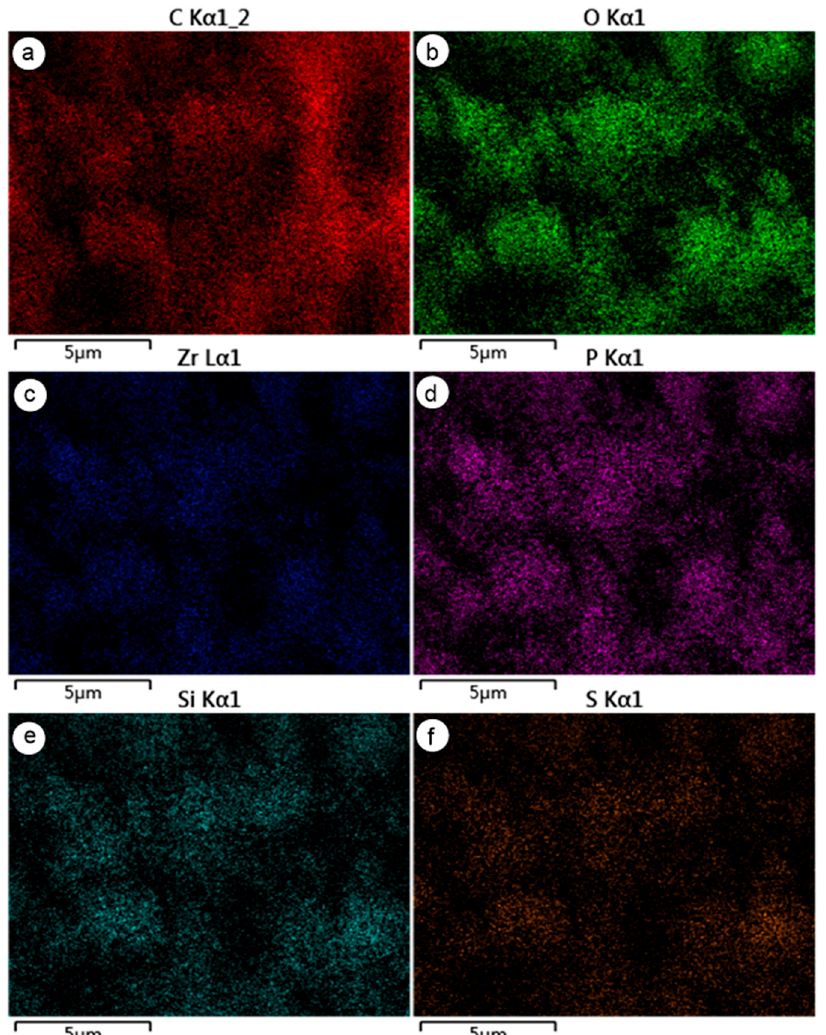
Figure 6. EDX elementary mapping of ( a ) C, ( b ) O, ( c ) Zr, ( d ) P, ( e ) Si, and ( f ) S in the catalyst ZPS–